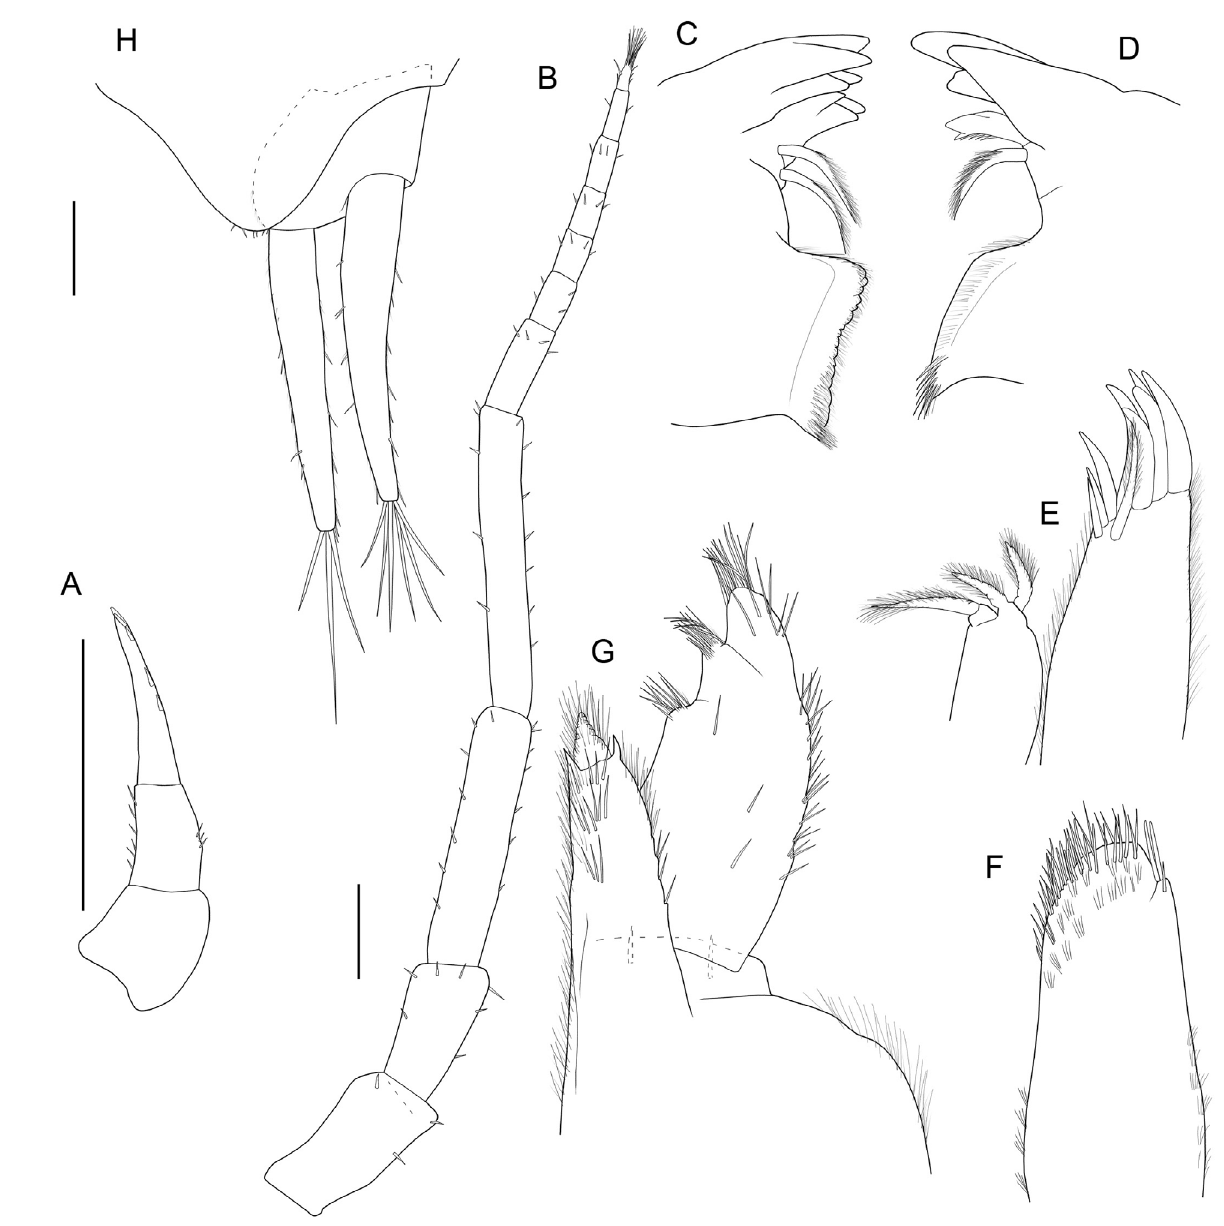
Figure 2. Spelunconiscus castroi Campos-Filho, Araujo and Taiti, 2014. A : Antennule, B : antenna; C : left mandible; D : right mandible; E : maxillule; F : maxilla; G : maxilliped; H : uropod. Scale bar: 0.2